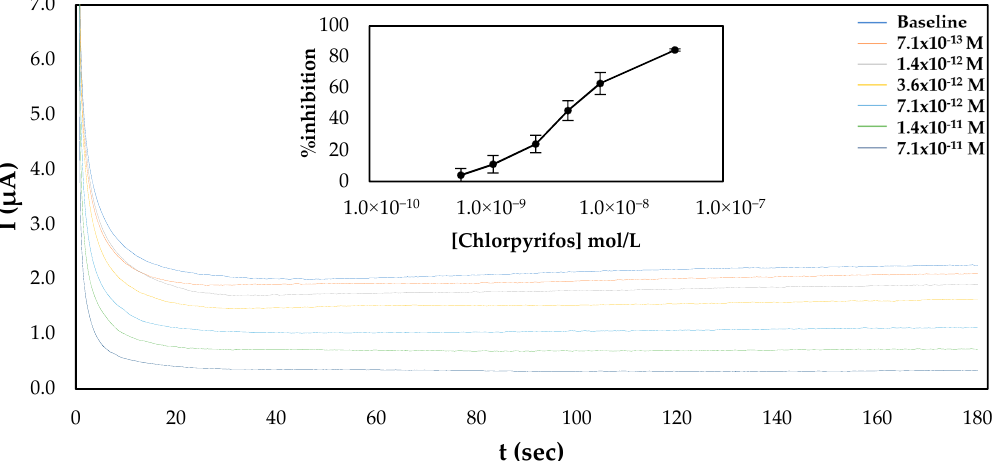
Figure 5. Characteristic amperograms of current recorded over time for the uninhibited enzyme (baseline) and following incubation with increasing concentrations of chlorpyrifos (standard samples) for CB/CS/AChE-modified electrodes fabricated following the one-step approach at a constant applied potential of +250 mV. The graph shown in the inset shows the mean % inhibitions of different concentrations of carbofuran obtained from 5 different electrodes.